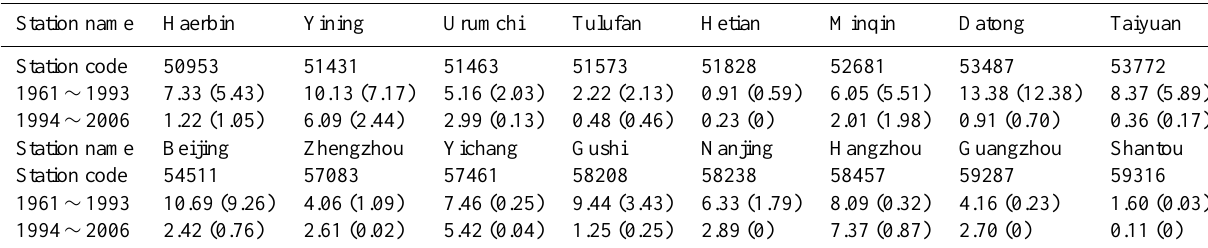
Table 1. The rates of obviously erroneous and suspected data for two separate time periods (1961 ∼ 1993 and 1994 ∼ 2006) at all 16 radiation stations that contain continuous time series from 1961 to 2006. The numbers in parentheses are the rates of data with obvious positive biases. The unit of the rate is percentage (%).